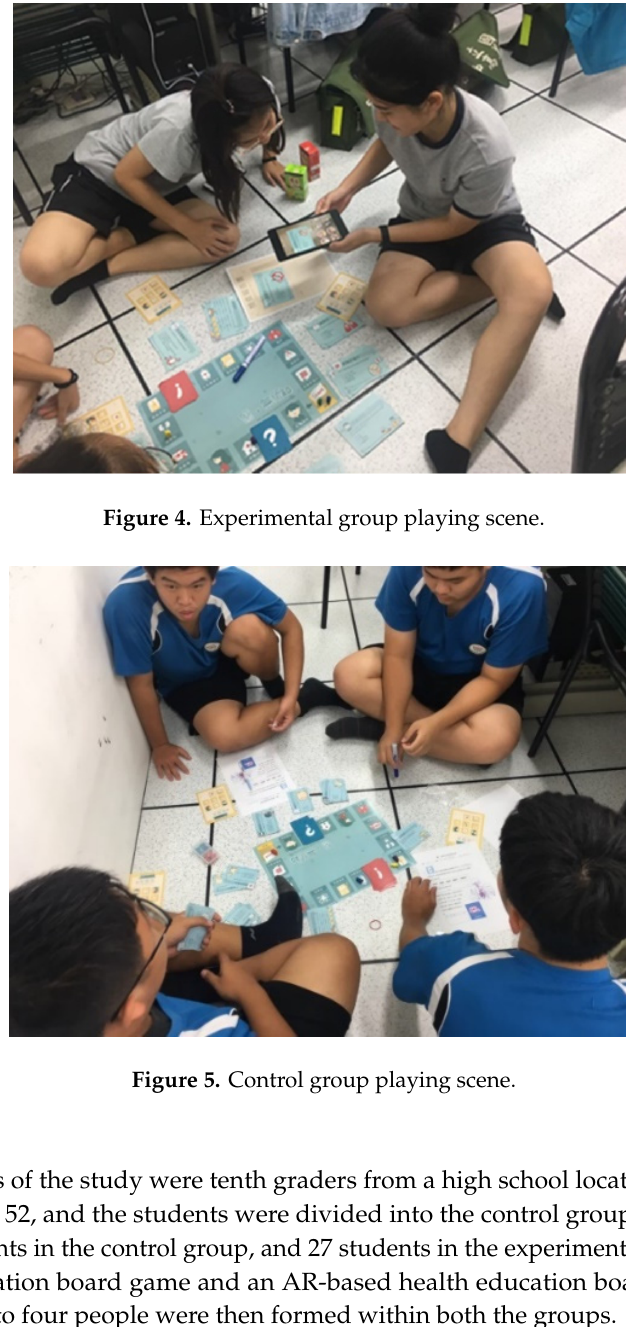
Figure 3. The research conceptual framework.